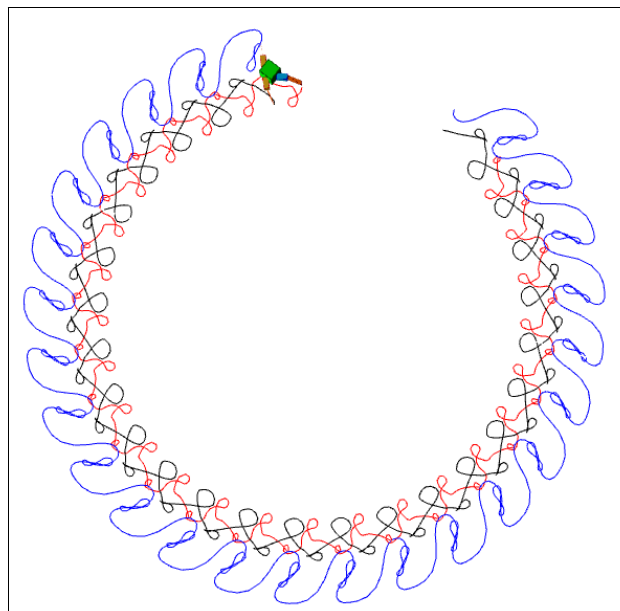
FIGURE 14 | Snapshots, a less well performing circular locomotion ( E = 0.5), performed by a swimming robot .The figure shows a sequence of color coded fin tip movements (as in Figure 13 ) indicating the circular path taken by the robot (which does not score as well as straight line motion). Again it can be seen that the fins make regular, repeated, fairly complex